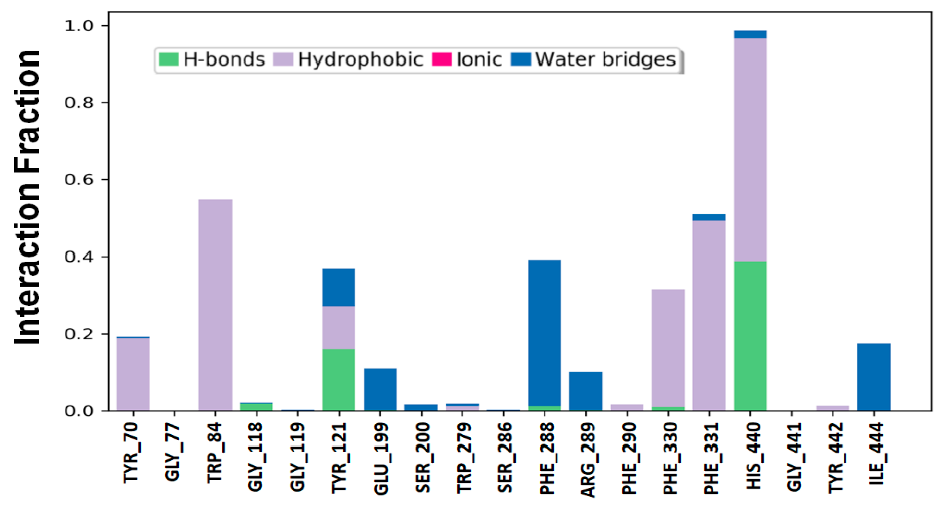
Figure 8. Interactions between AChE and